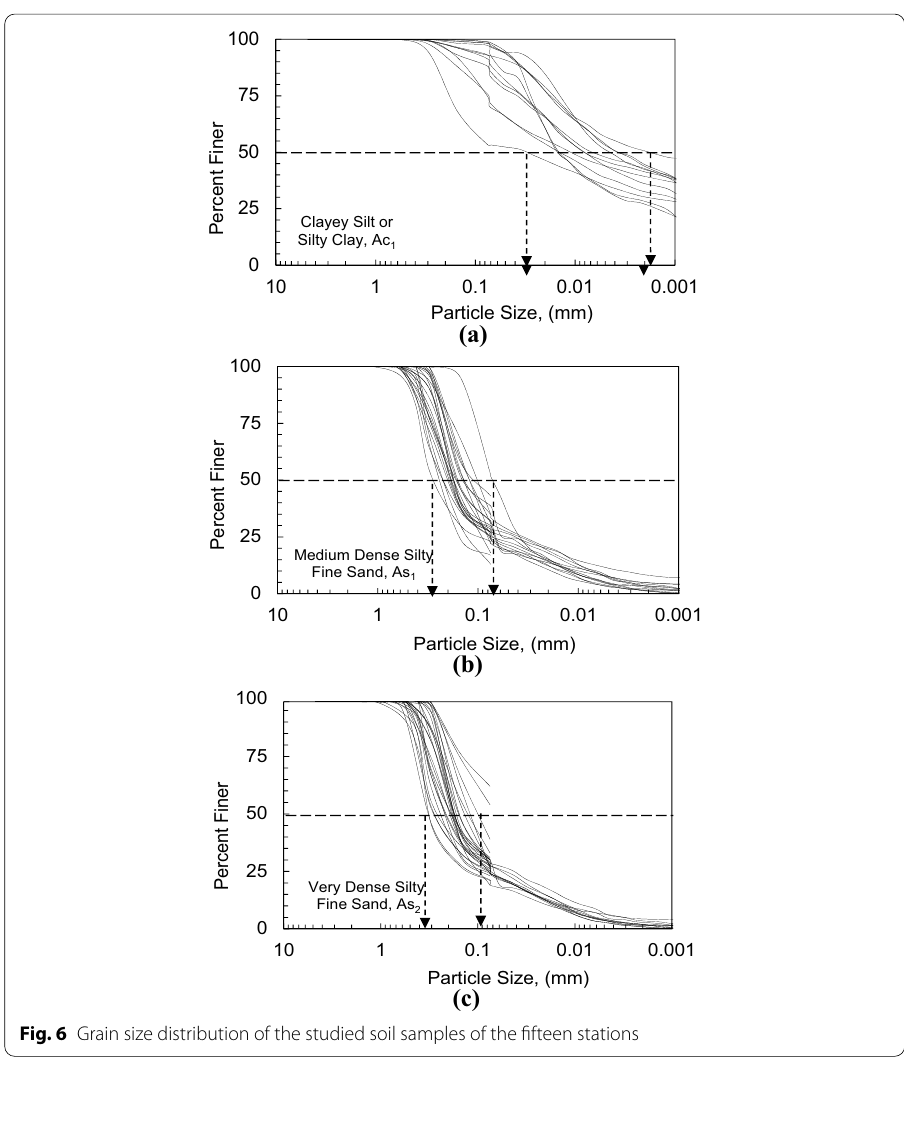
Fig. 6 Grain size distribution of the studied soil samples of the fifteen stations